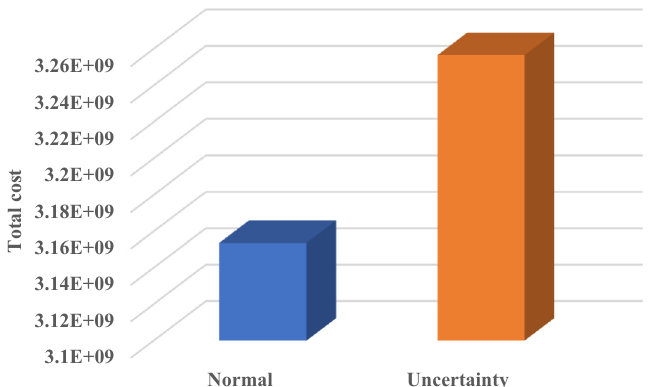
Figure 15. Total cost under uncertainty framework.